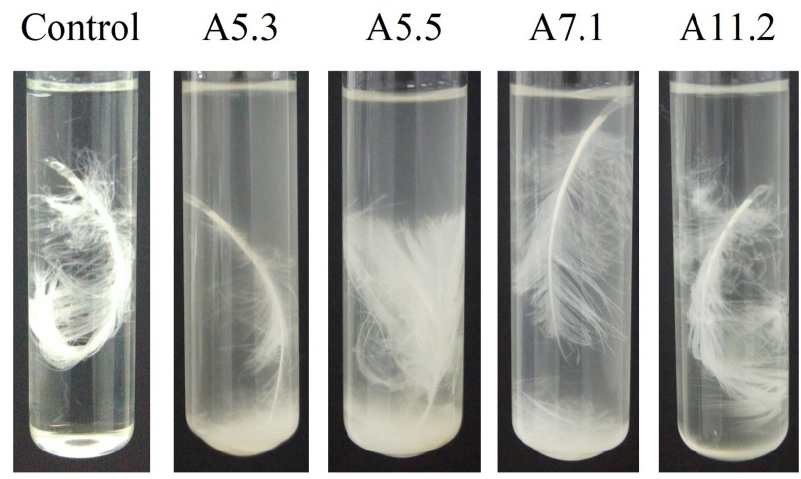
Figure 2. Feather degradation by Bacillus isolates A5.3, A5.5, A7.1, and A11.2.